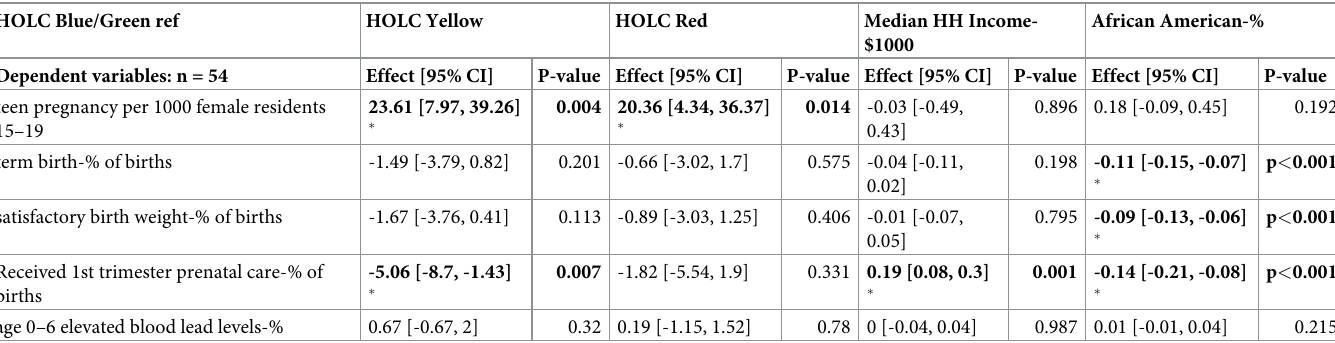
Table 4. Multivariable ordinary least squares analysis of Baltimore HOLC and 2013 maternal and child health outcomes and processes.